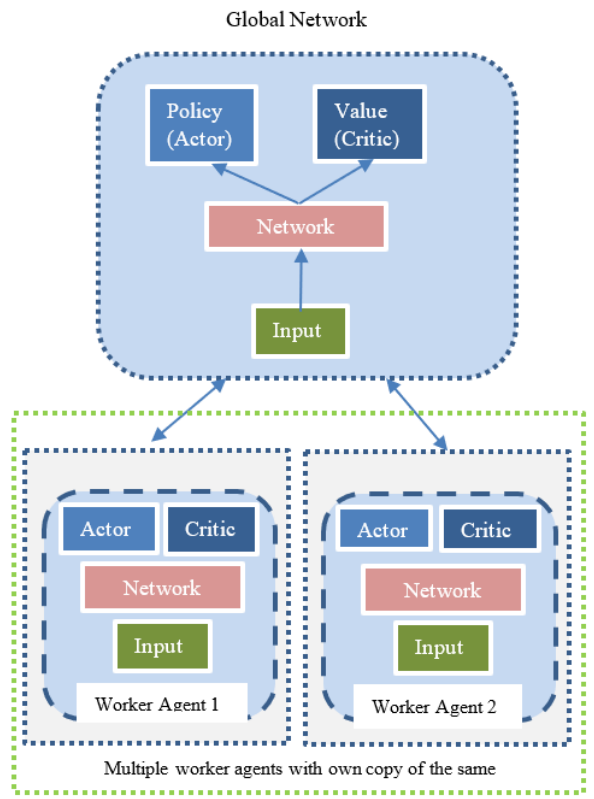
Figure 3. Architecture of the asynchronous actor-critic model.